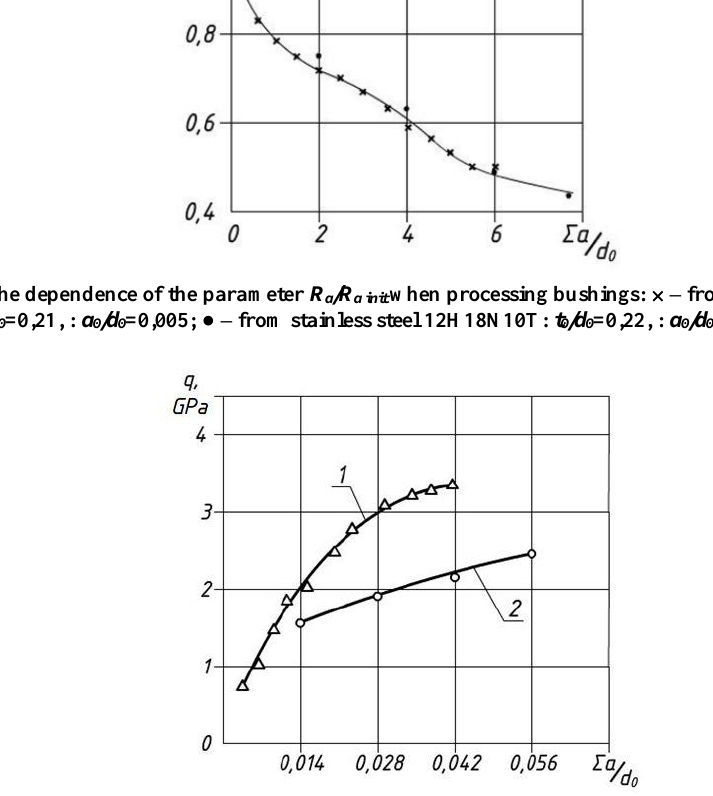
Fig. 6. The dependence of contact pressure on the total deformation during the processing of the bushings: 1 – from titanium VT1-0: t 0 /d 0 =0,21, a 0 /d 0 =0,028, l = 0.65 mm; 2 – from stainless steel 12H18N10T: t 0 /d 0 =0,22, : a 0 /d 0 =0,014, l = 1.5 mm